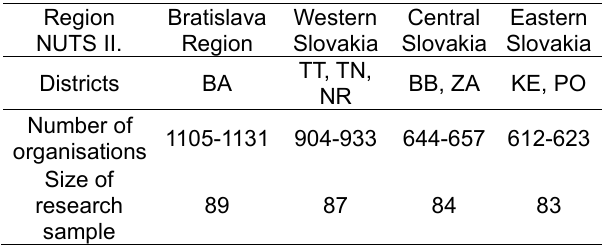
Table 3. Size of the research sample for individual regions of Slovakia (source: own